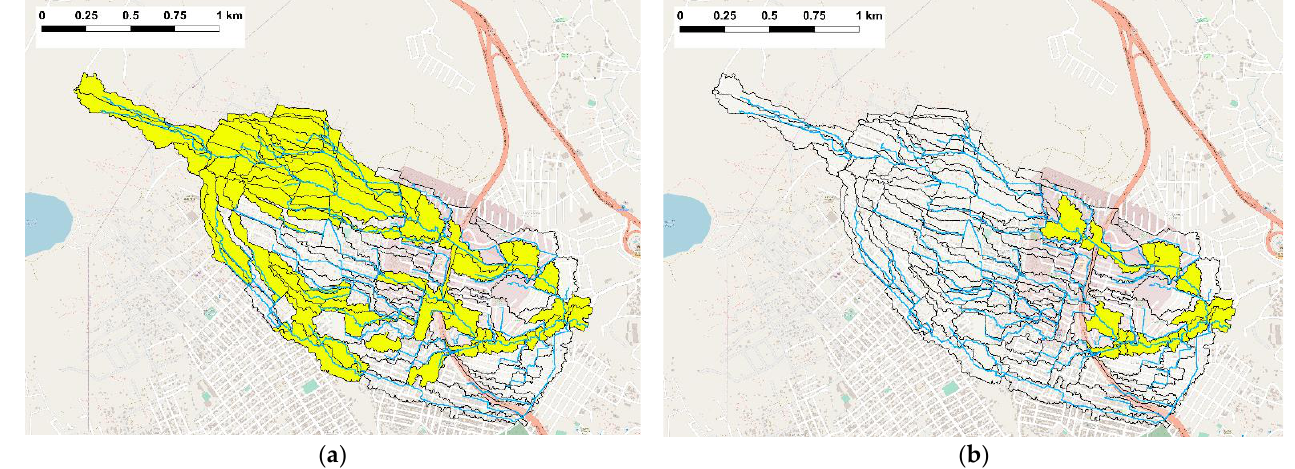
Figure 11. Comparison of all the basins involved for implementing mitigation measures (colored in yellow): ( a ) all the sub-basins with natural streams; ( b ) selected sub-basins with natural streams. For 100-year design storm in May (Figure 12a), revegetating all the natural streams alone successfully decreases the flood peak by 22% without delaying the arrival of the